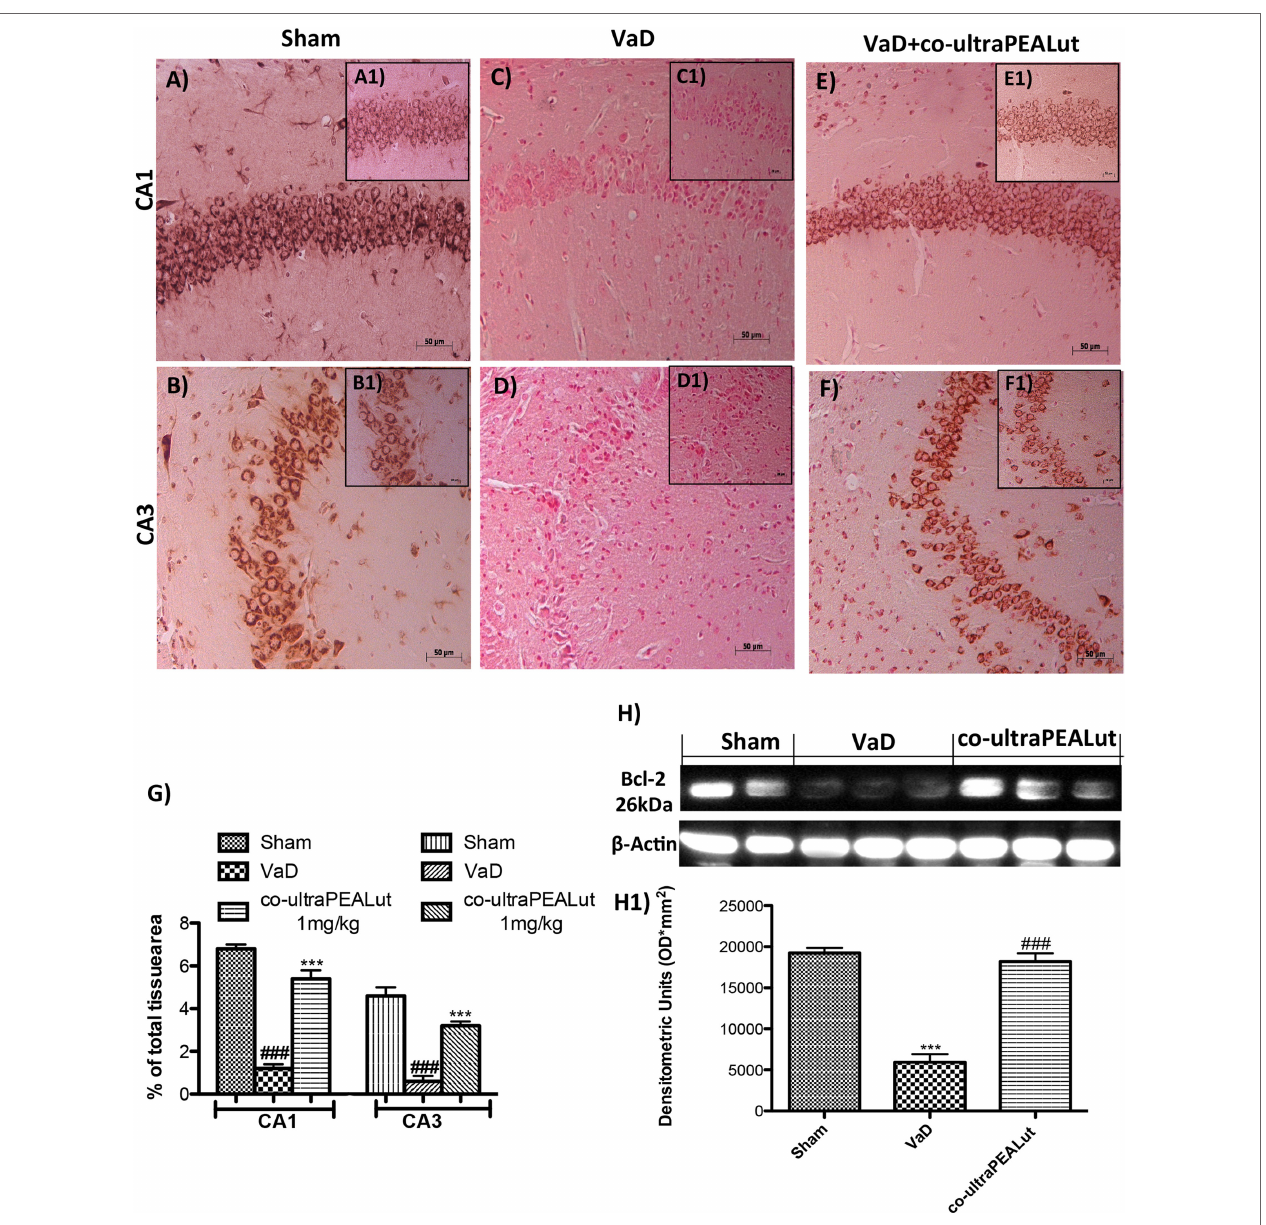
FigUre 6 | effects of co-ultraPealut on antiapoptotic protein in VaD mice . A significantly positive immunostaining for Bcl-2 was found in Sham group and in mice after co-ultraPEALut administration (a,a1,B,B1,e,e1,F,F1,g) , while VaD mice showed a decreased expression of Bcl-2 in hippocampal CA1 and CA3 regions (c,c1,D,D1,g) . Moreover, Western blot analysis demonstrated that Bcl-2 expression was reduced after carotid arteries occlusion; however, treatment with co-ultraPEALut restored basal levels (h,h1) . The data are illustrative of at least three independent experiments. (g) *** p < 0.001 vs. Sham; ### p < 0.001 vs. VaD; (h) *** p < 0.001 vs. Sham; ### p < 0.001 vs. VaD, as determined by one-way ANOVA followed by Bonferroni post hoc test.